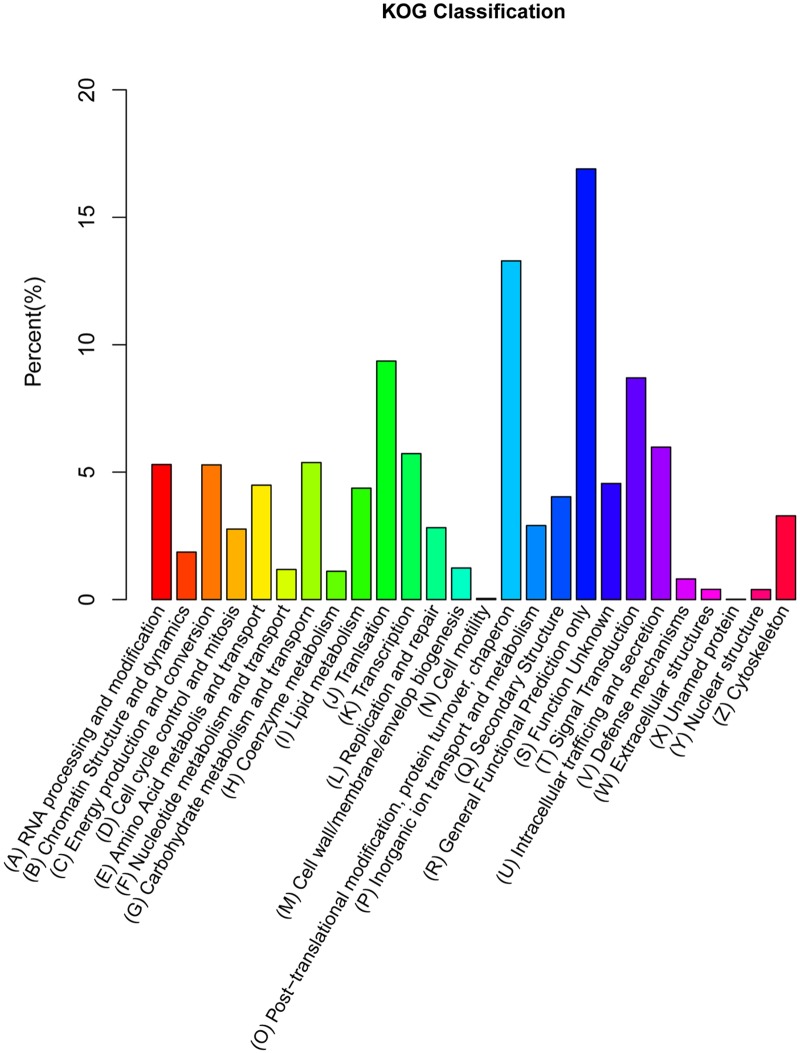
Histogram of KOG classification.The 8,645 unigenes were grouped into 25 KOG categories.